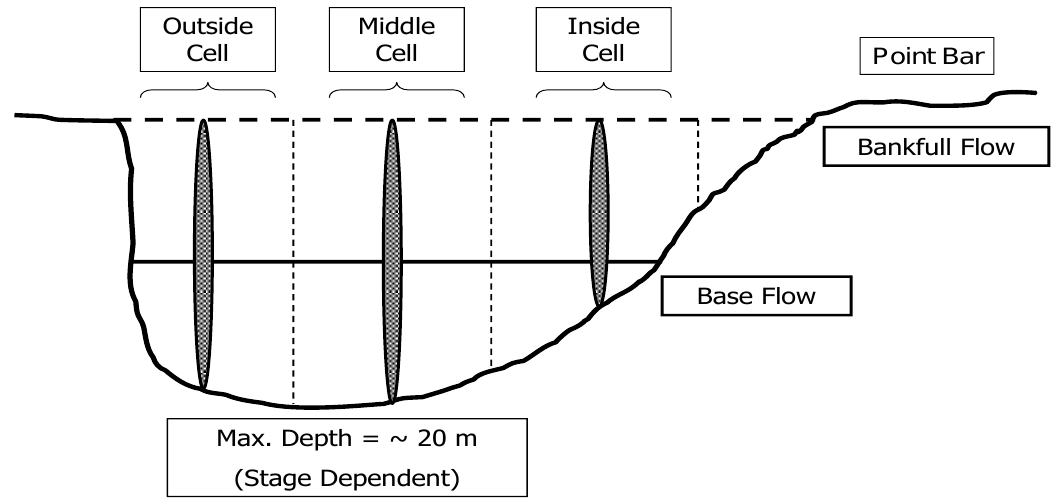
Figure 4. Depiction of sampling cells (Inside, Middle, and Outside) across a habitat transect. Shaded area represents sample collection location within a cell. Riffle thalweg located along inside bank, lateral scour pool and glide thalwegs located along outside bank. Illustration created by A.J.P